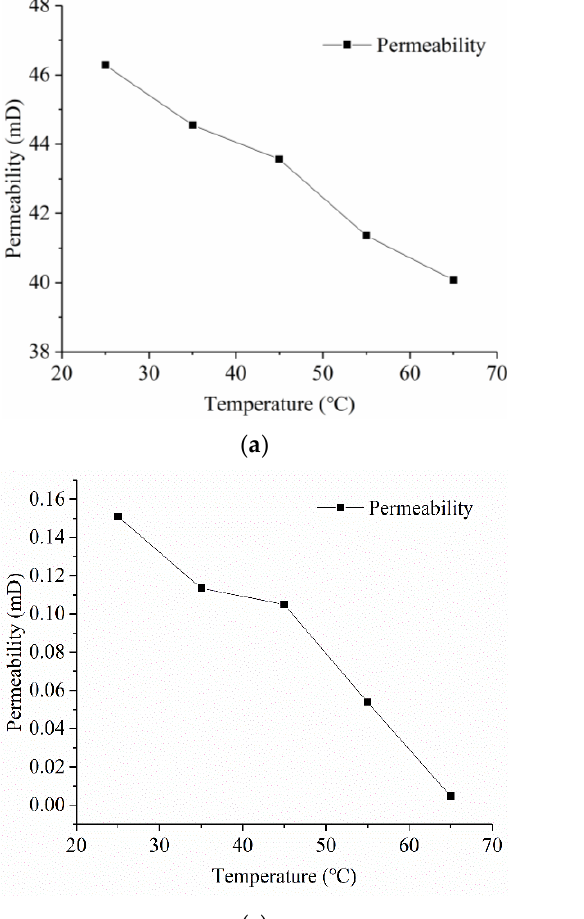
ture: ( a ) subcategory I 1 sandstone; ( b ) subcategory I 2 sandstone; ( c ) subcategory II 1 sandstone;